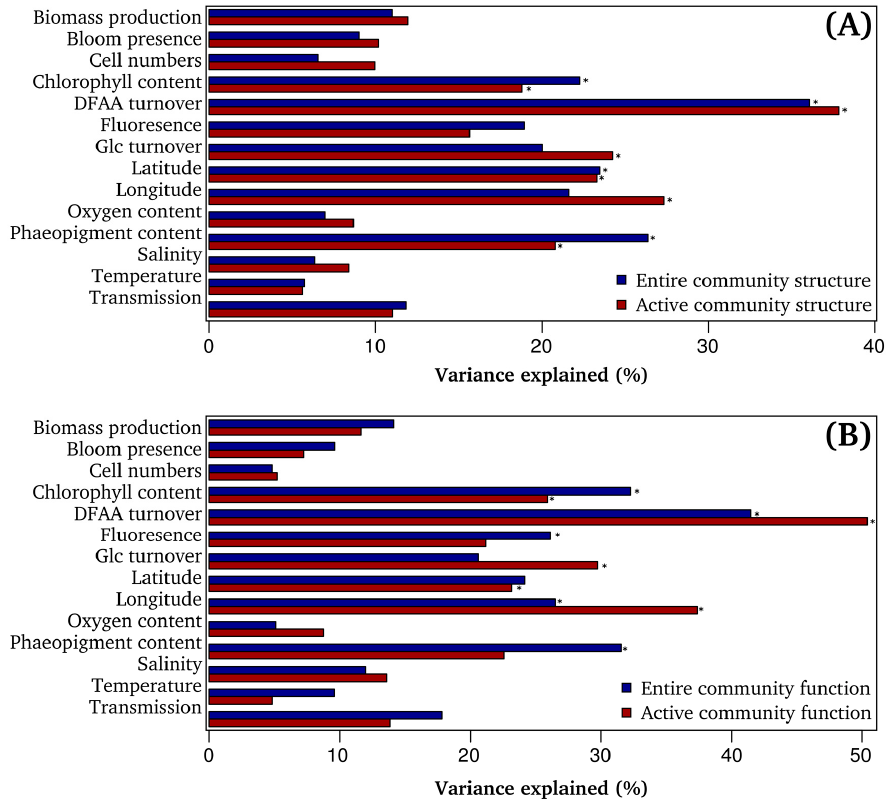
Figure 4. Correlation between environmental and microbial properties and observed bacterial community composition (A) as well as predicted functional profiles (B). Given is the coefficient of determination. Stars mark significant correlations. The correlation was tested by permutational multivariate analysis of variance (PERMANOVA) with 999 permutations.